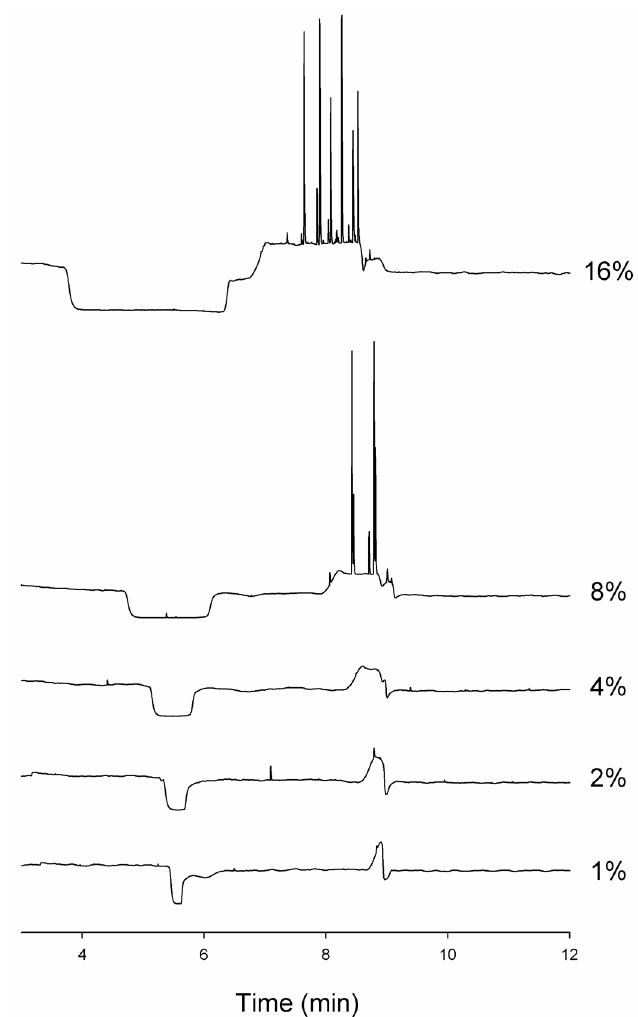
Figure 3. Analysis of 13-day incubated A β 1-40. Running buffer as in Figure 1. Hydrodynamic injection (0.5 psi) under duration ranging from 10 to 160 s, leading to percentage of sample plug length vs. effective capillary length ranging from 1% to 16%. Major spikes can be observed only with a ratio ≥ 8% (injection time ≥ 80 s). The number of spikes seems to increase according to the lengthening of injection time.